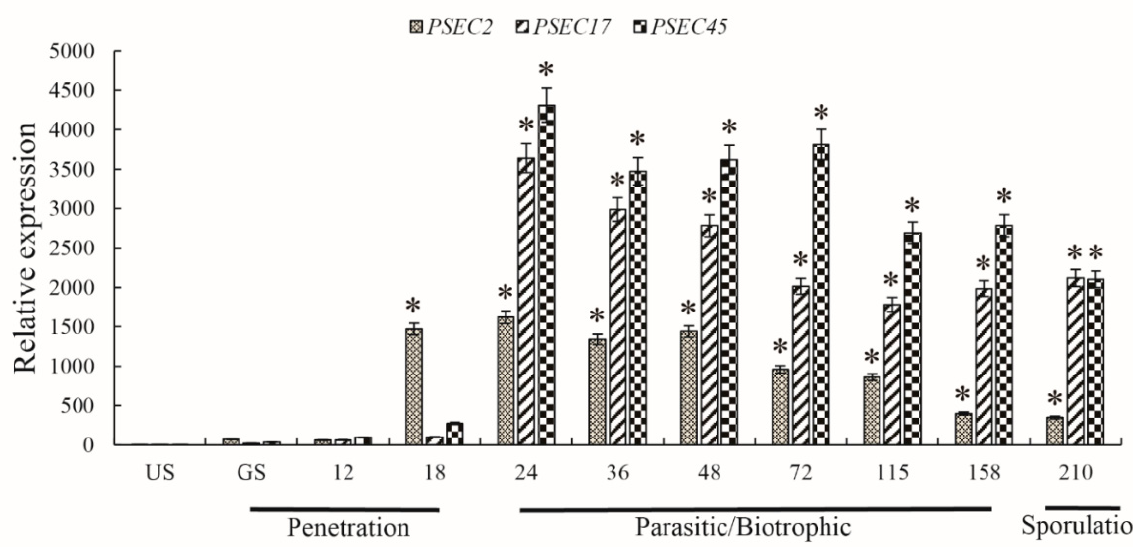
Figure 9. Transcription profiles of PSEC2 PSEC17 , and PSEC45 based on quantitative real-time PCR (qRT-PCR). US, urediniospore stage; GS, germ tube stage; 12–210 h, 12–210 h post-inoculation of CYR32 in wheat MY11. The relative gene quantification was calculated by the comparative threshold (2 − ∆∆ CT ) method with Pst endogenous gene EF1 as an internal standard and was relative to that of US. Bars indicate means of three independent biological replicates ( ± SD). * indicates p < 0.05.